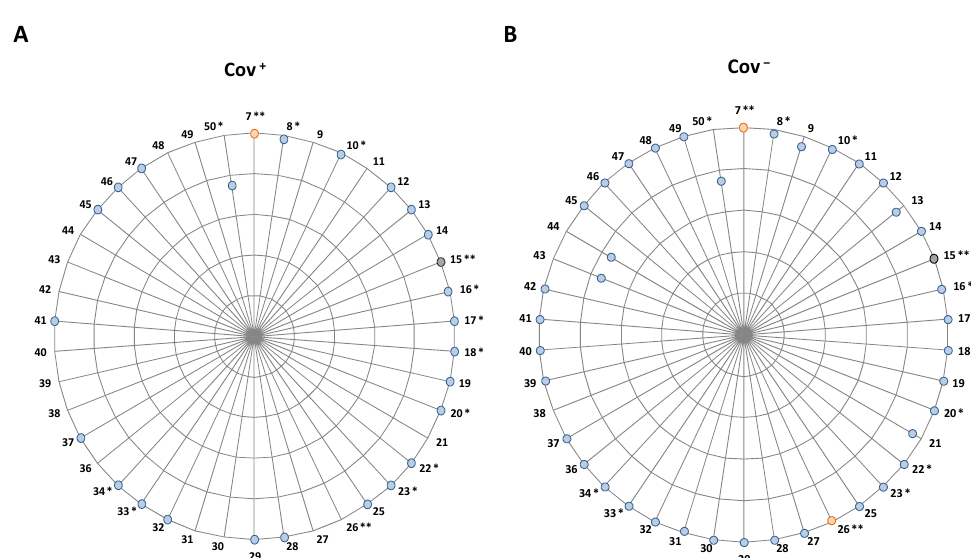
Figure 2. Radar plot depicting the seroconversion rates. Each colored dot represents the level of antibody response in the corresponding study included in the literature review on a 0–100% scale (with 20% points increment). Each level of the radar represents a percentage level, from 0% (i.e., center of the radar) to the outermost one (i.e., 100%): the further away from the center, the higher the observed HCW seroconversion rate. ( A ) reports the antibody response assessed within one month after two doses of vaccine in previously infected HCWs (Cov+) and ( B ) in the naive ones (Cov − ). Studies for which data were reported for Cov+ and Cov − subjects without any separation are identified by an asterisk *; studies for which another time point was reported are identified by a double-asterisk **; the colors of the dots are the same of that used in Table S2 to highlight the different timepoints (blue: antibody assessment within one month after the second dose; orange: antibody assessment at three to six months after the second dose; black: antibody assessment ≥ six months after the second dose).